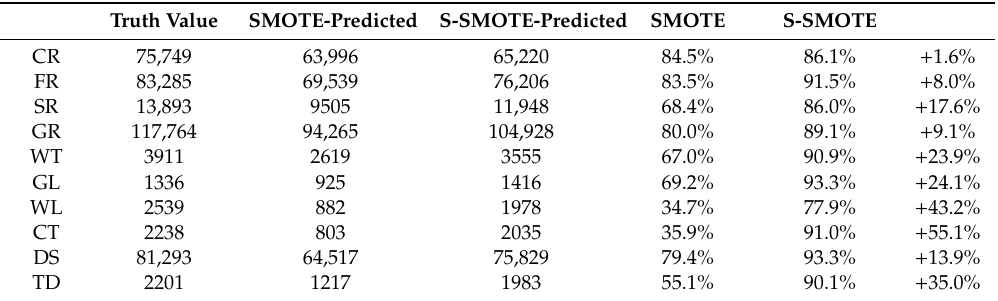
Table 6. SMOTE algorithm and stratified SMOTE algorithm precision